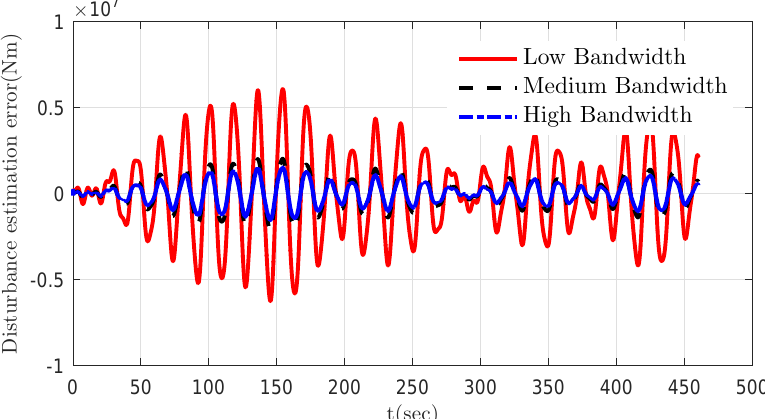
Figure 10. Disturbance estimation comparisons with different ESO